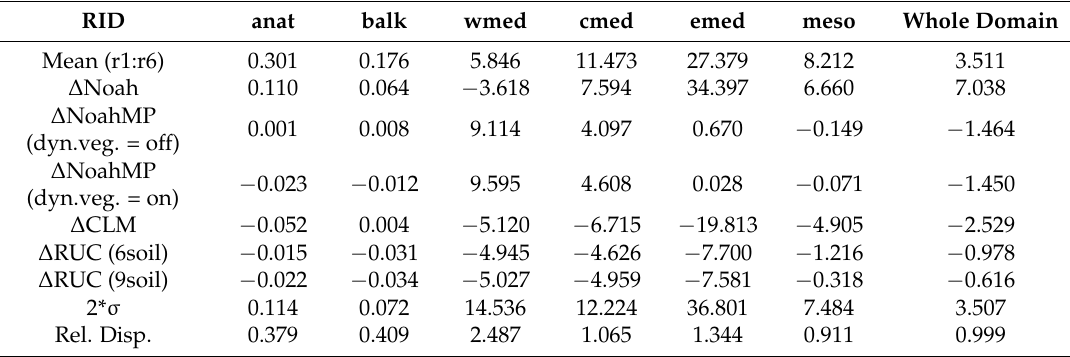
Table 2. Mean values of RID derived from the six experiments, the difference ( ∆ ) of each run from the overall mean value, two times standard deviation and the “relative dispersion” for the six sub-domains (Anatolia, Balkans, western, central & eastern Mediterranean and Mesopotamia) and the reduced MENA domain. RID anat balk wmed cmed emed meso Whole Domain Mean